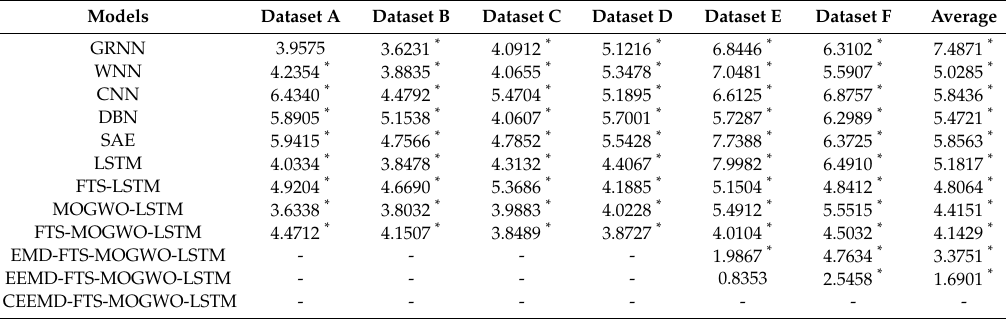
Figure 10. The forecasting results from Wednesday and Sunday as well as the basic data descriptions. Table 9. Results for the Diebold–Mariano (DM)